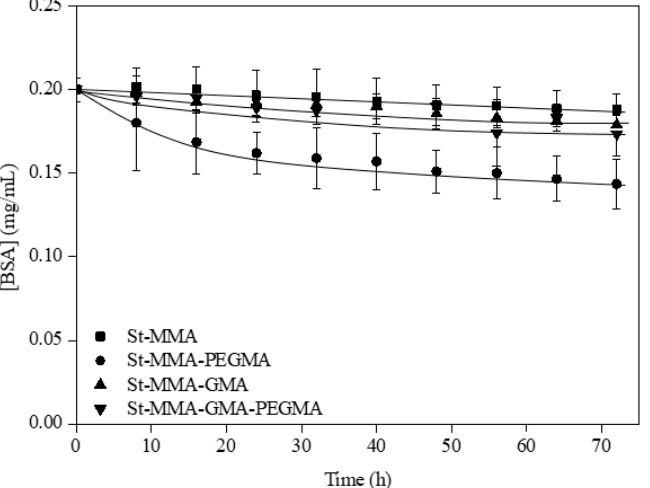
Figure 7. Kinetics of BSA immobilization in non-wetted particles. All of the experiments were carried out with 2.5 g of particles, at 25 °C and with a flow rate of 8 mL/min